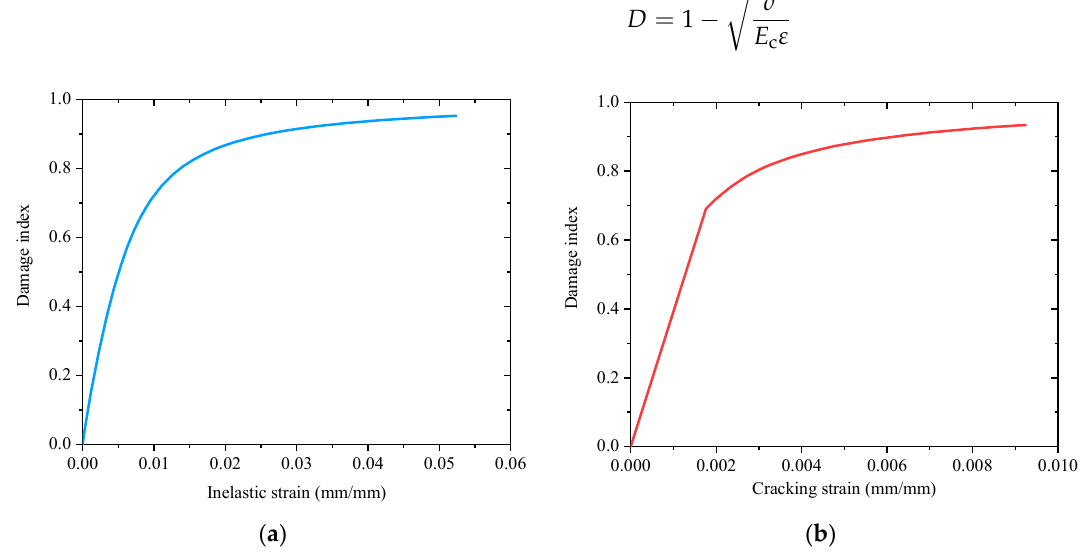
Figure 9. Damaged index–strain curve of the UHPC: ( a ) compression; ( b ) tension.